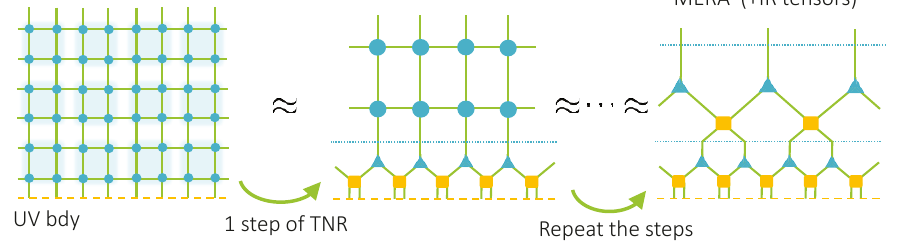
Figure 4 . The tensor network renormalization (TNR) gradually makes the coarse-grained tensor network with removing short-range entanglement. From the UV boundary, isometries (coarse- graining) and unitaries (disentanglers) accumulate and the MERA network grows with the TNR